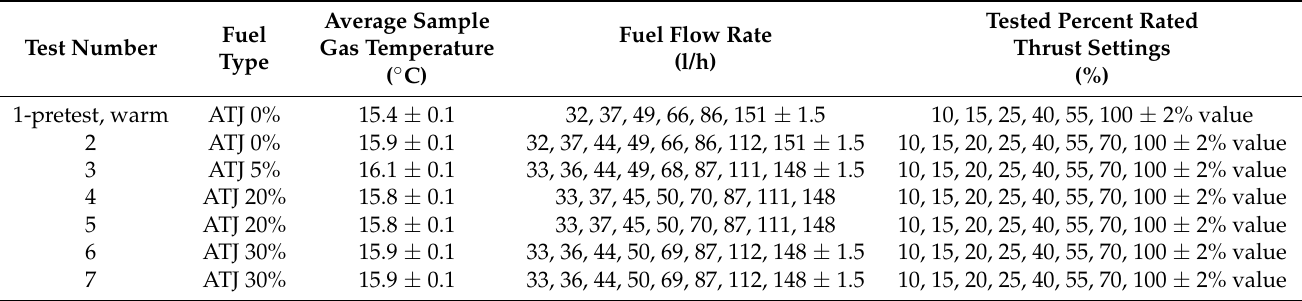
Table 3. Engine test